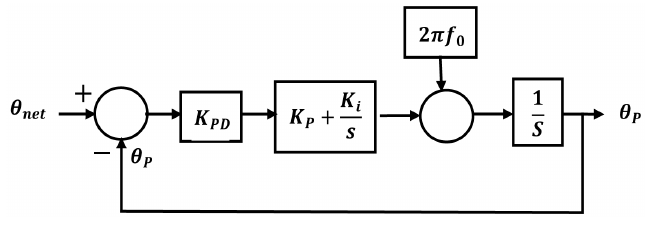
Figure 3. Linear model of SRF-PLL [12].